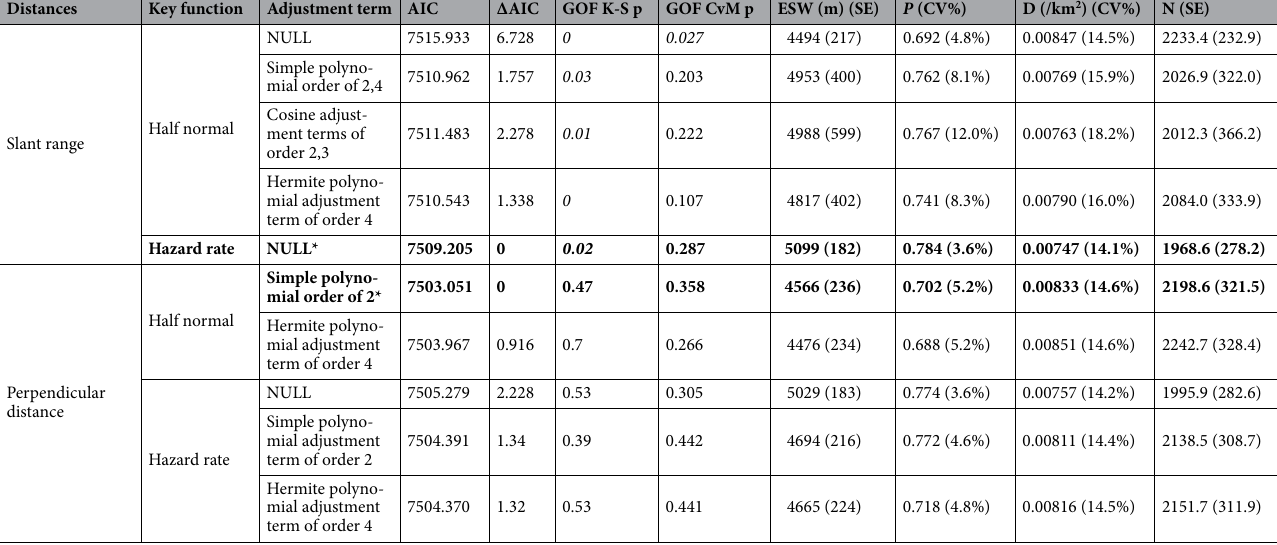
Table 4. Results for the best five models fitted to slant ranges and depth-corrected perpendicular distances using R package Distance. Goodness of fit (GOF) scores are based on the 95% confidence level, where P values that failed are italic. Asterisks and bold denotes the preferred model based on AIC. Estimates represent the number of animals using the study area during the study period (summer, 2016). Detections outside the truncation distance of 6500 m were excluded. ESW Effective strip half-width (m). P = probability of detection, D the total density estimate (N/area), N the total estimate of abundance, CV% the coefficient of variation. SE standard